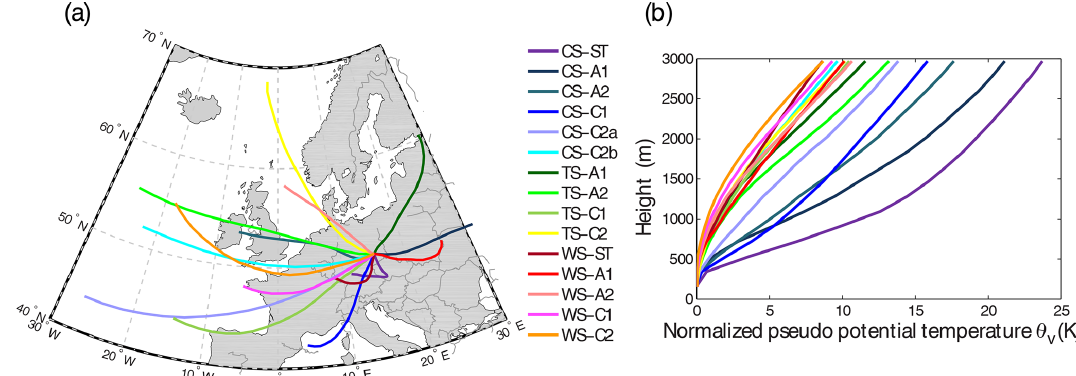
Figure 8. (a) The 15 back-trajectory clusters terminated at MEL. (b) Average normalised profiles of pseudo potential temperature ( θ v ) for the 15 clusters.